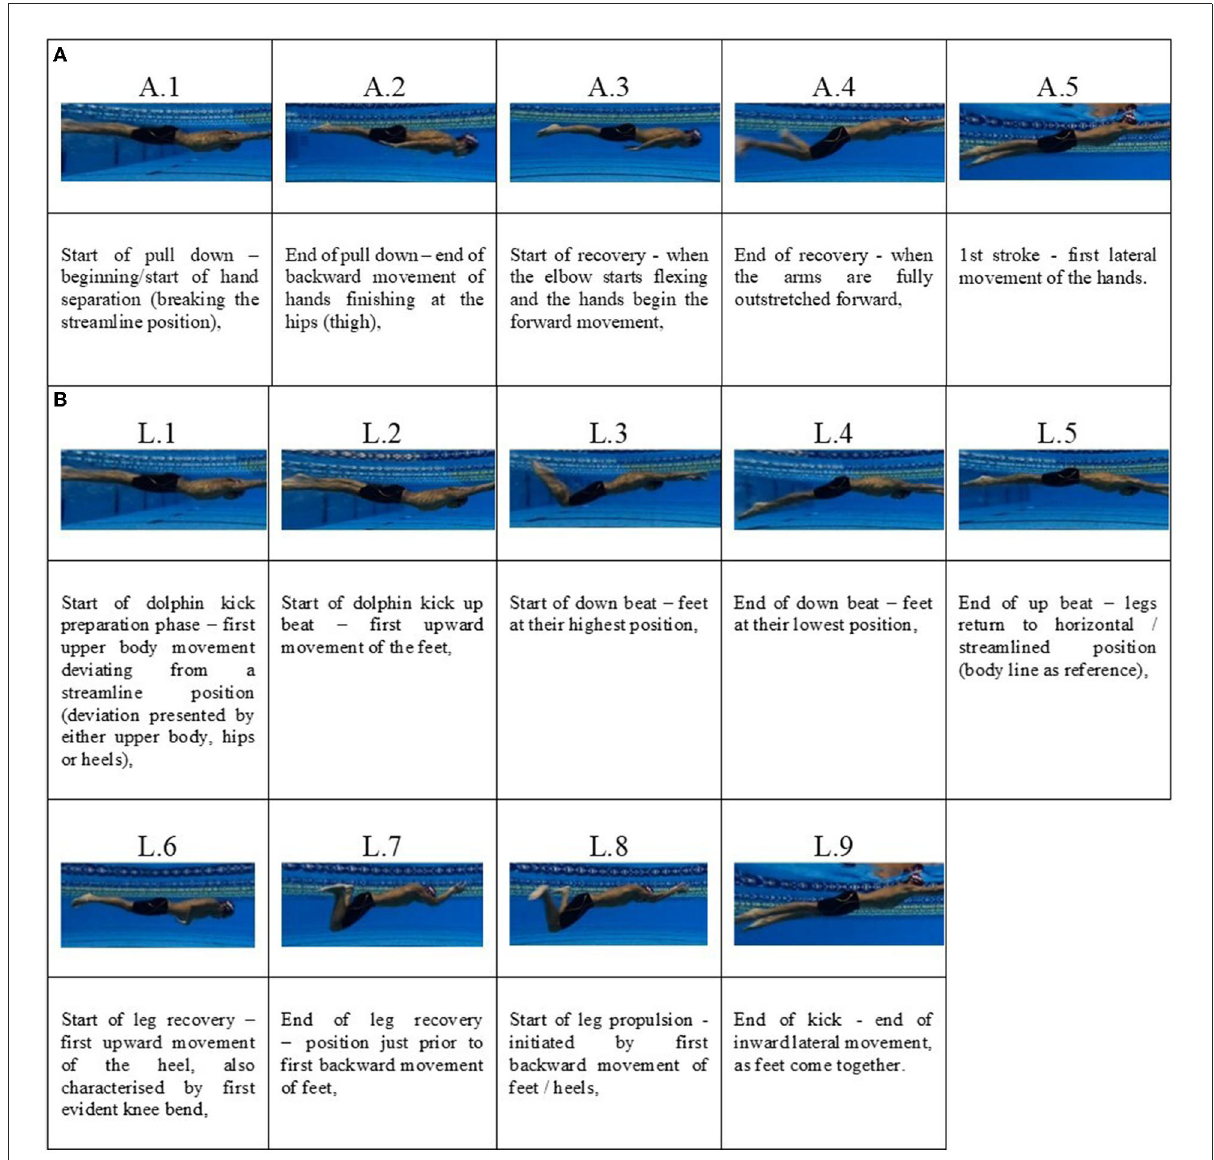
FIGURE1 (A) Identification of key movement positions during the breaststroke underwater pullout phase with respect to the arm actions (A.1 to A.5) [A = arm]. (B) Identification of key movement positions during the breaststroke underwater pullout phase with respect to the leg actions (L.1 to L.9) [L =